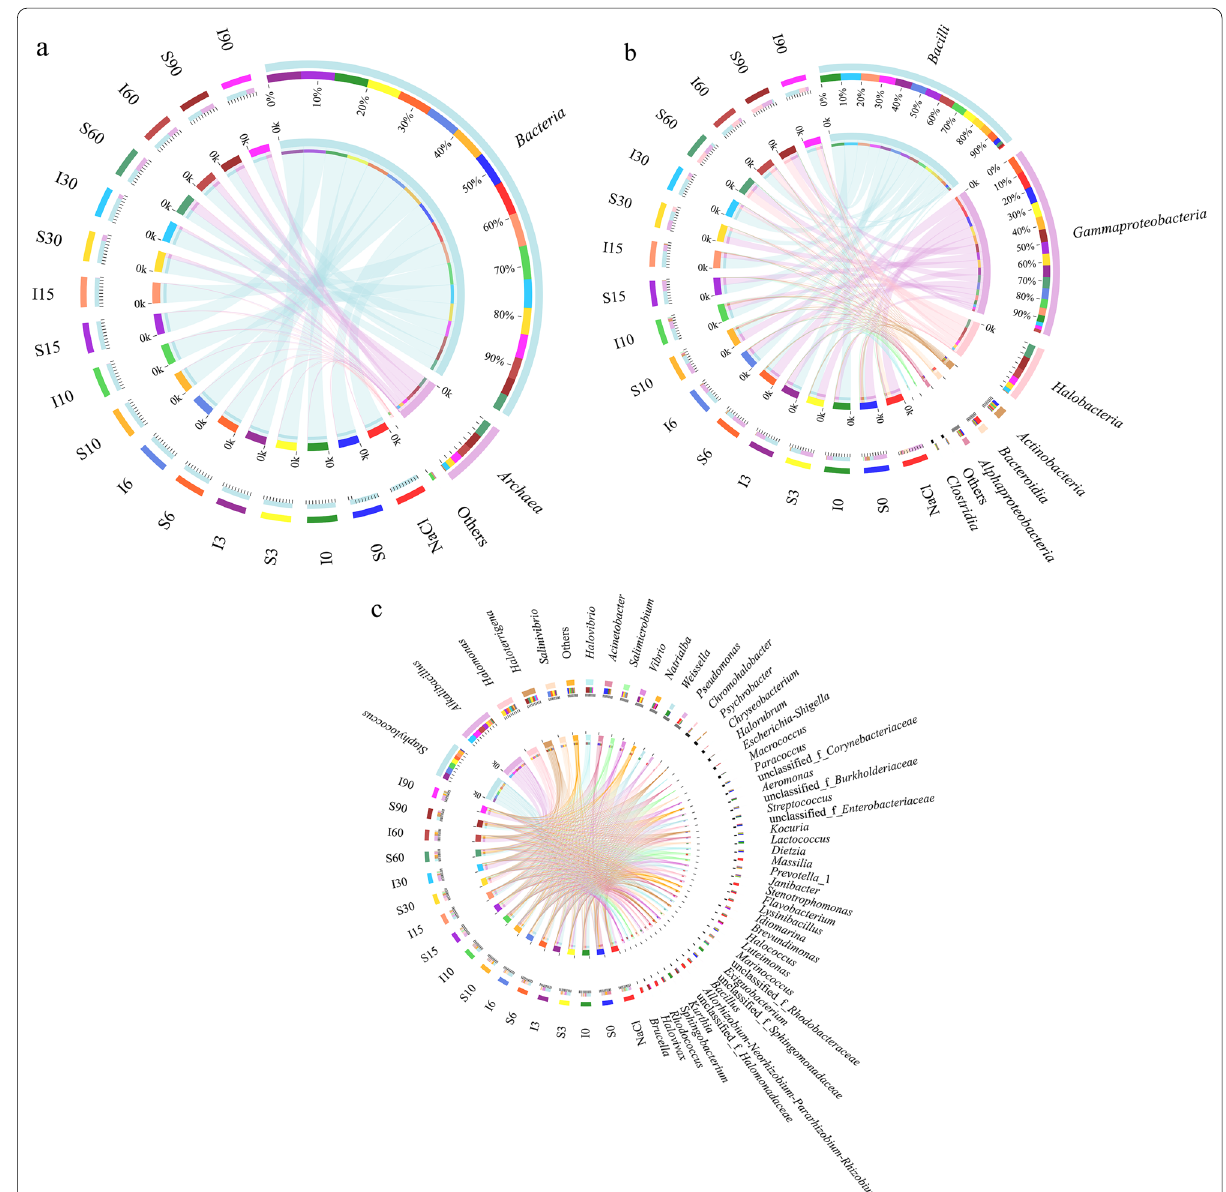
Fig. 2 Circos string diagram of the correlation between microbial samples and species abundance in wet-salted goatskin at different times: a domain level; b phylum level; c genus